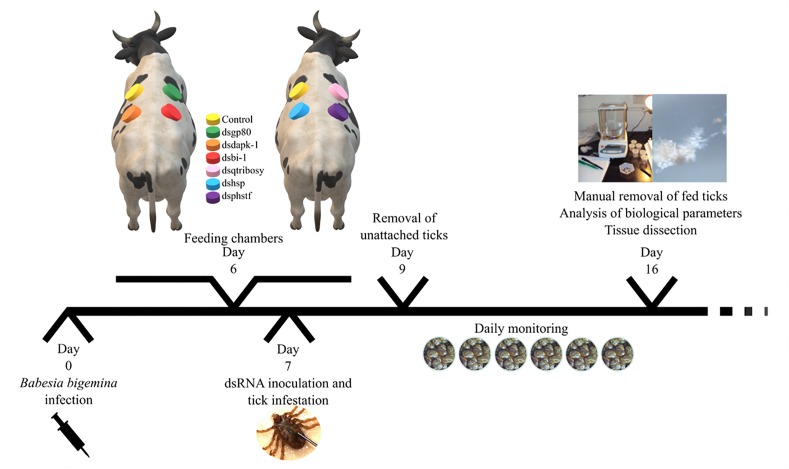
Experimental design of silencing assay. Two 6 months-old calves were inoculated intravenously with B. bigemina-infected blood. After 6 days, cotton cloth chambers were glued to the calf skin (one day before infestation). In day 7, thirty specific-dsRNA inoculated female ticks were added to its respective feeding chambers together with thirty males. Two days after infestation (day 9) unattached ticks were removed from the patches. Ticks were monitored daily and allowed to feed on the infected calves for 7 days. After this period, attached ticks were manually removed and stored in a humidity chamber until further use (analysis of biological parameters and tissue dissection).